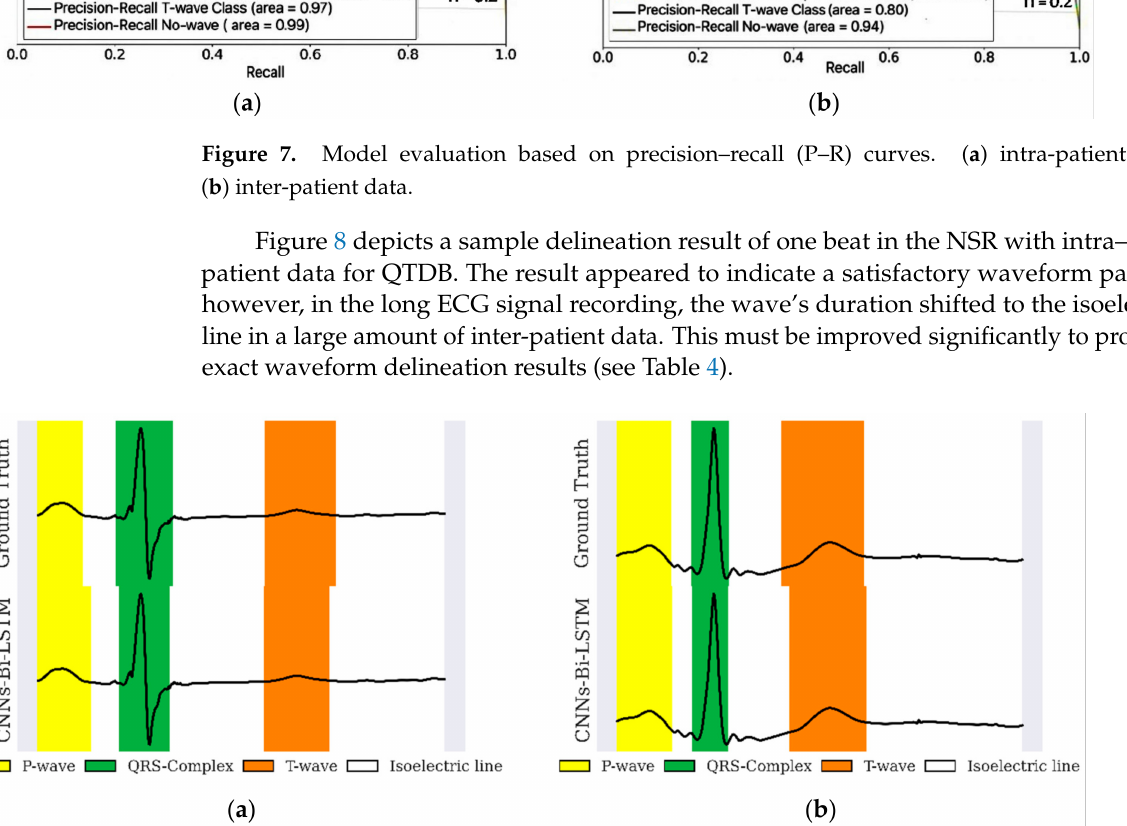
Figure 8. A sample of one-beat ECG signal delineation results for ( a ) intra-patient and ( b ) inter- patient in NSR data. Each figure represents the QTDB ground truth (top figure) and CNNs-Bi-LSTM (bottom